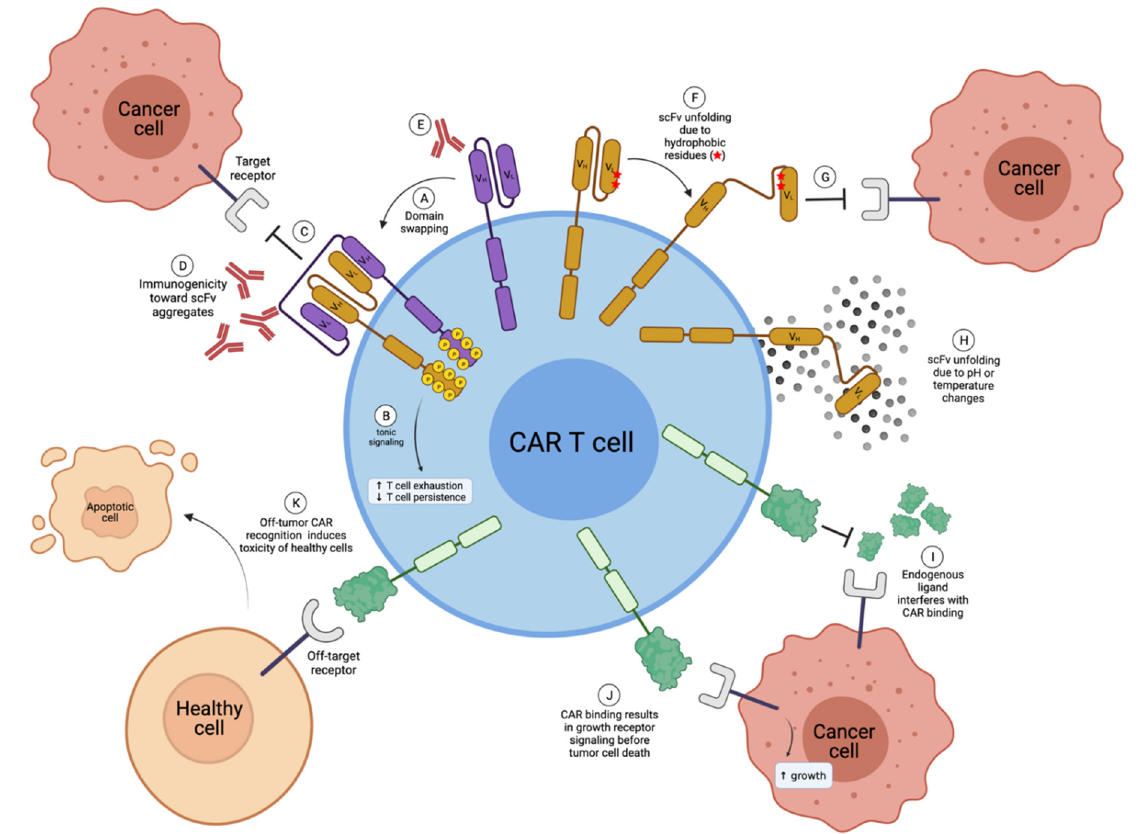
Figure 3. Disadvantages of scFv-based and natural receptor- or ligand-based CAR T cells. ( A ) Multiple scFvs can undergo domain swapping, where the V H of one scFv will incorrectly pair with the V L of another scFv, creating CAR aggregates; ( B ) CAR aggregates induce tonic signaling in CAR T cells, which is known to enhance T-cell exhaustion and decrease T-cell persistence in vivo; ( C ) scFv aggregates can no longer bind to the target receptor; ( D ) receptor aggregates can be immunogenic; ( E ) in some cases, scFvs can be immunogenic; ( F ) hydrophobic residues within scFvs can cause unfolding; ( G ) unfolded scFvs are no longer able to bind to the target receptor; ( H ) scFv unfolding can also be due to pH or temperature changes, for example during freeze-thaw cycles; ( I ) endogenous ligand (or receptors) may interfere and compete with CAR binding for the target antigen in the case of natural receptor-based or ligand-based CARs; ( J ) natural receptor- or ligand-based CAR binding may induce detrimental target receptor cell signaling; ( K ) natural receptor- and ligand-based CARs can have greater off-target toxicity. V H ; Variable heavy chain. V L ; Variable light chain. Created with BioRender.com.